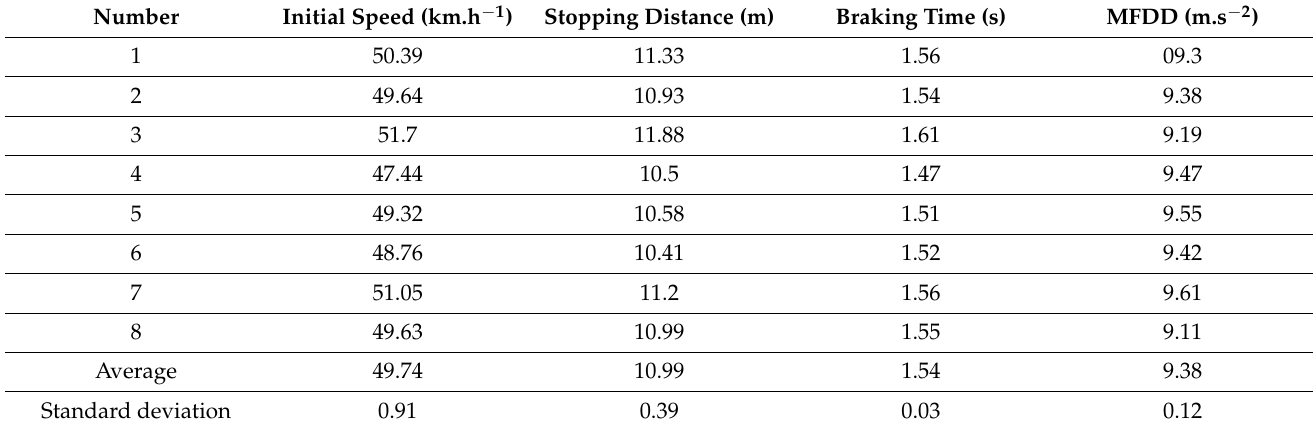
Table 7. Braking characteristics measured with high-priced brake components.